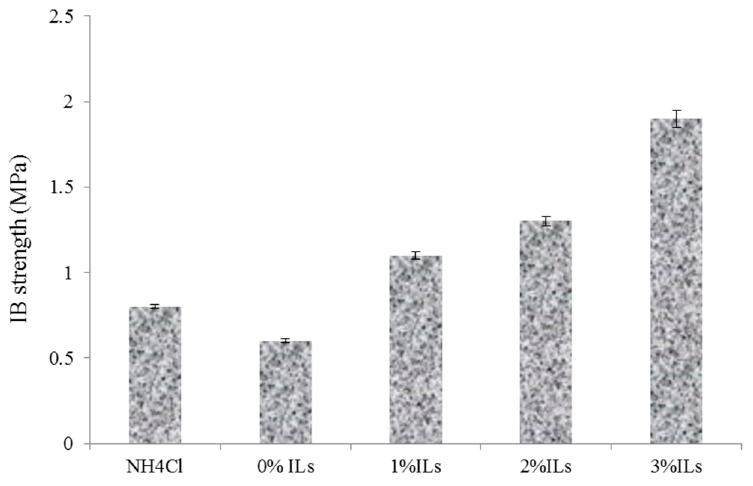
Figure 11. Internal bond strength (IB) of the manufactured particleboard made from synthesized resins.